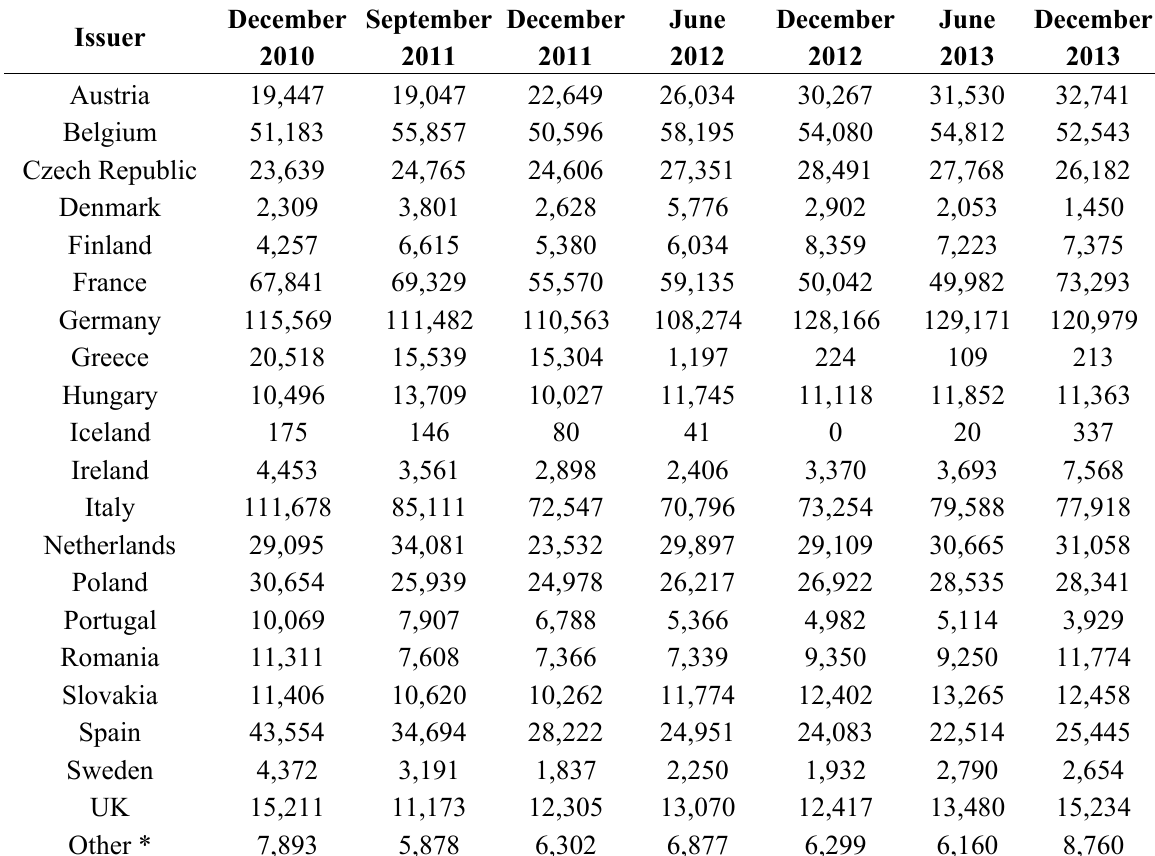
Table 4. Aggregated Sovereign Debt Portfolios of Core Banks without Home Bias (values in millions of